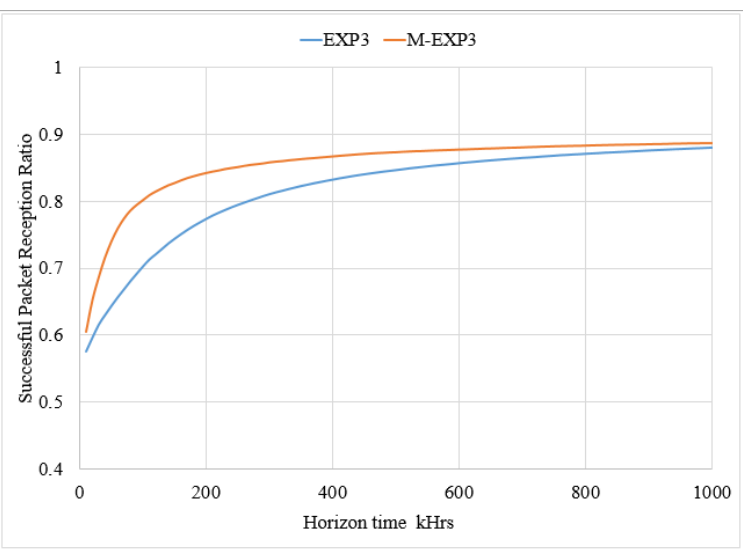
Figure 5. Comparison of the successful packet reception